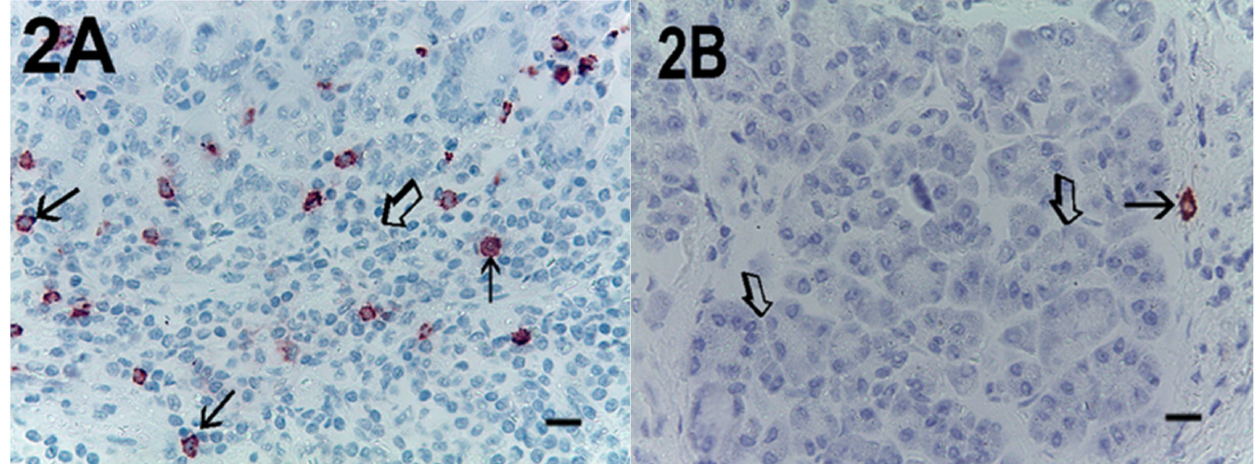
Figure 2. Magnification × 400, 0.19 mm 2 area, immunostaining with the anti-tryptase antibody. ( A ) High MCDPT in primary PDAT section. Small arrows indicate single red-immunostained MCs. The big arrow indicates tumour epithelium. ( B ) Low MCDPT in ANT section. The small arrow indicates just one red-stained MC. Big arrows indicate normal pancreatic epithelium. Scale bar corresponds to 125 µ m. MCDPT, density of mast cells positive for tryptase.